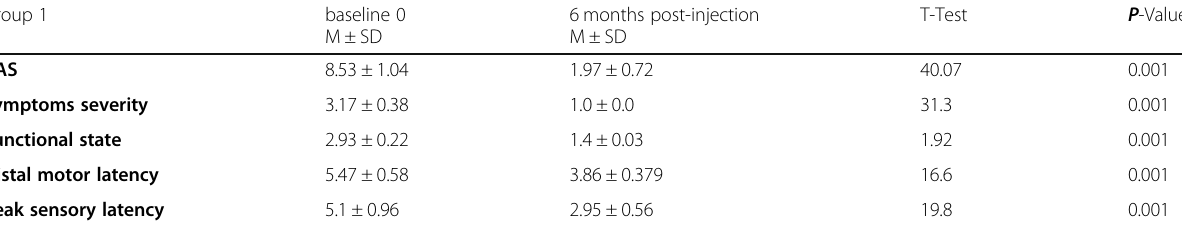
Table 2 Visual analogue scale, Boston questionnaire of CTS and electrophysiological parameters of median nerve in the first group of patients at 6 months post-injection compared to baseline parameters